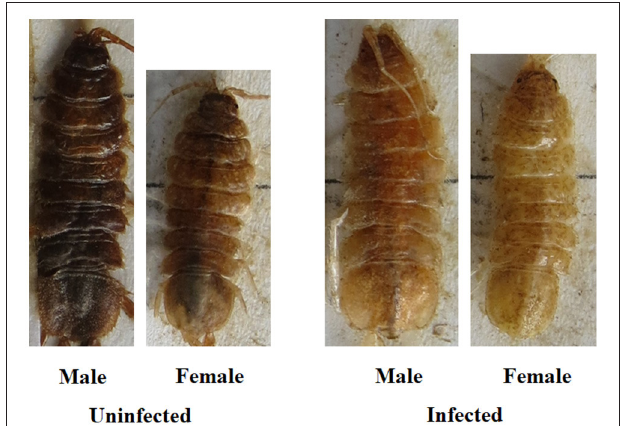
FIGURE 2 | Relationship between color, host sex, and infection status in C. intermedius . Shown are representative images of color variation for each of the four groups (uninfected males, infected males, uninfected females, infected females).